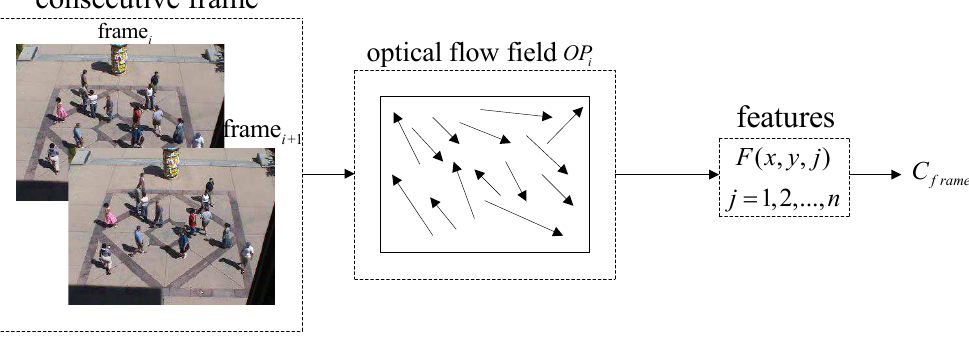
Table 1. Different choices of feature F to construct the covariance